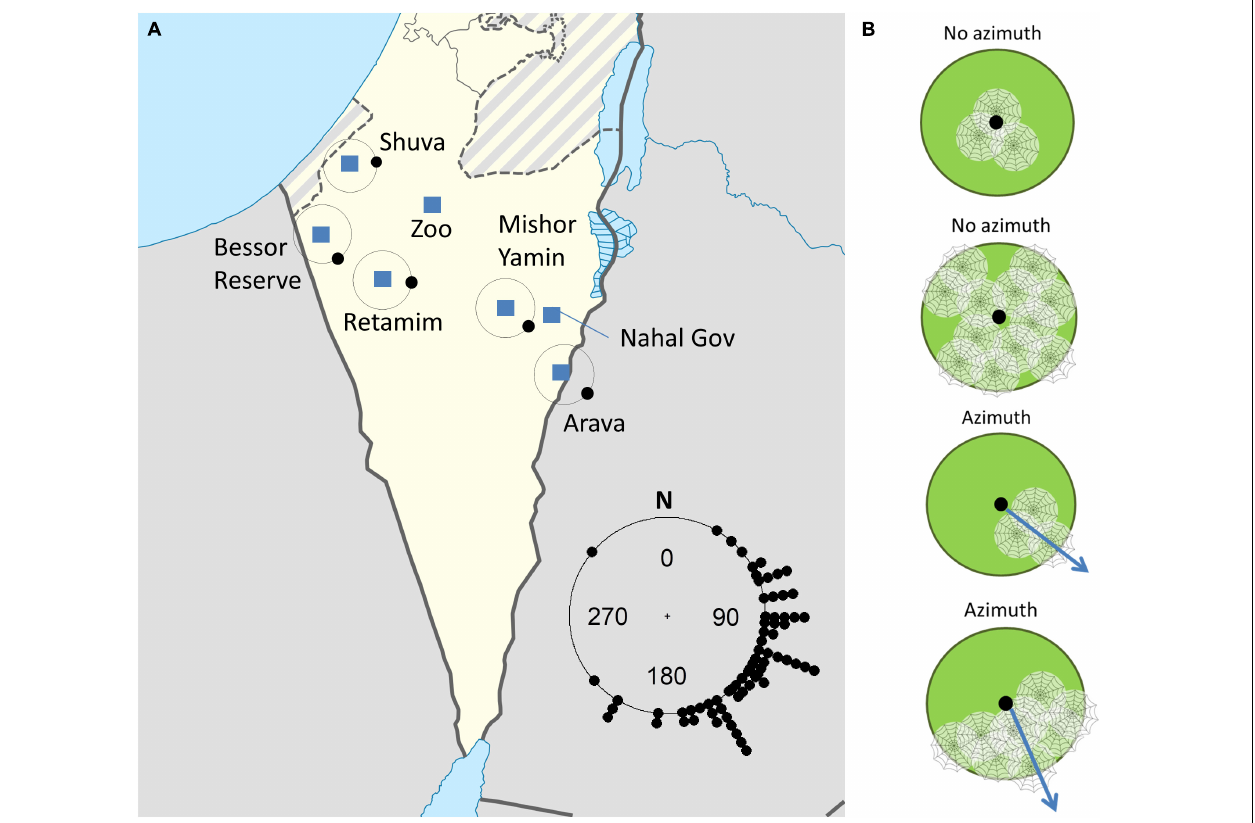
FIGURE 1 | (A) A map indicating the location of census sites (squares) and the average azimuth of colonies at each site (indicated by the black dot on the circle). No colony had a distinct azimuth at the Beer Sheva Zoo (Zoo), and Nahal Gov only had two colonies with distinct azimuths (average 160 degrees off north). The inset circle shows the azimuth of all colonies. (B) How azimuth was measured: the green circles represent substrates with the black dot indicating the substrate’s center. Colonies (web icons) in the center or occupying the entire substrate had no azimuth. For large colonies that spanned a range of degrees, we took the azimuth (blue arrows) from the middle of the